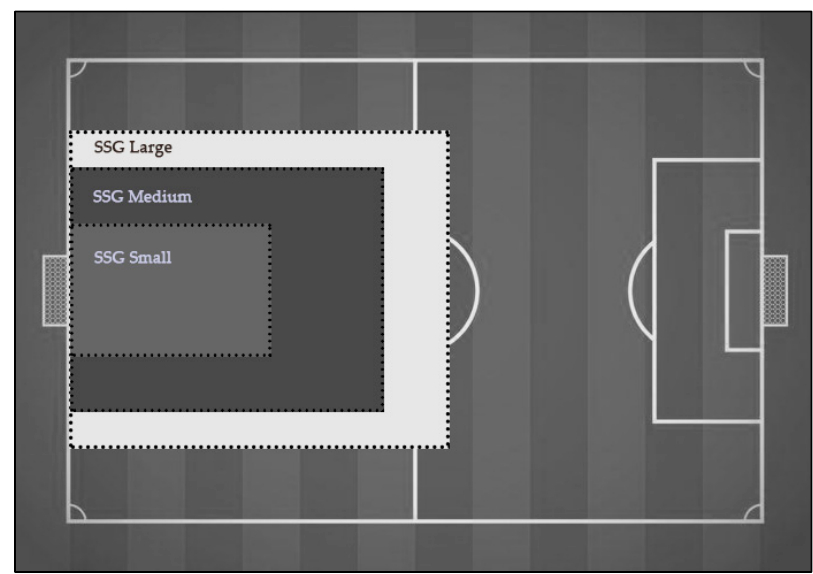
Figure 1. Three different pitch sizes of the SSG compared to the normal pitch size of a football pitch. The individual playing area did not take goalkeepers into account [36].